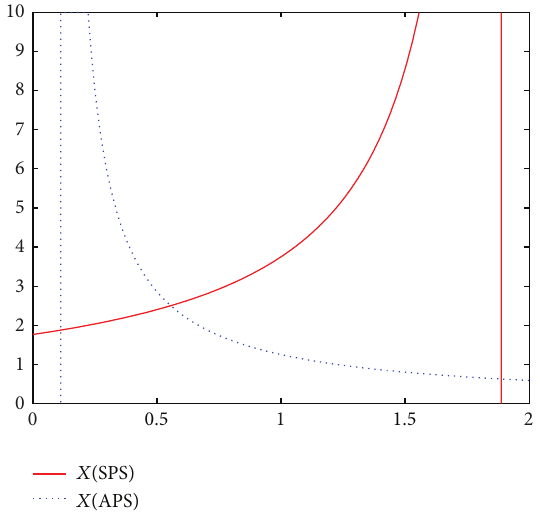
Figure 12: Total R&D inputs with product